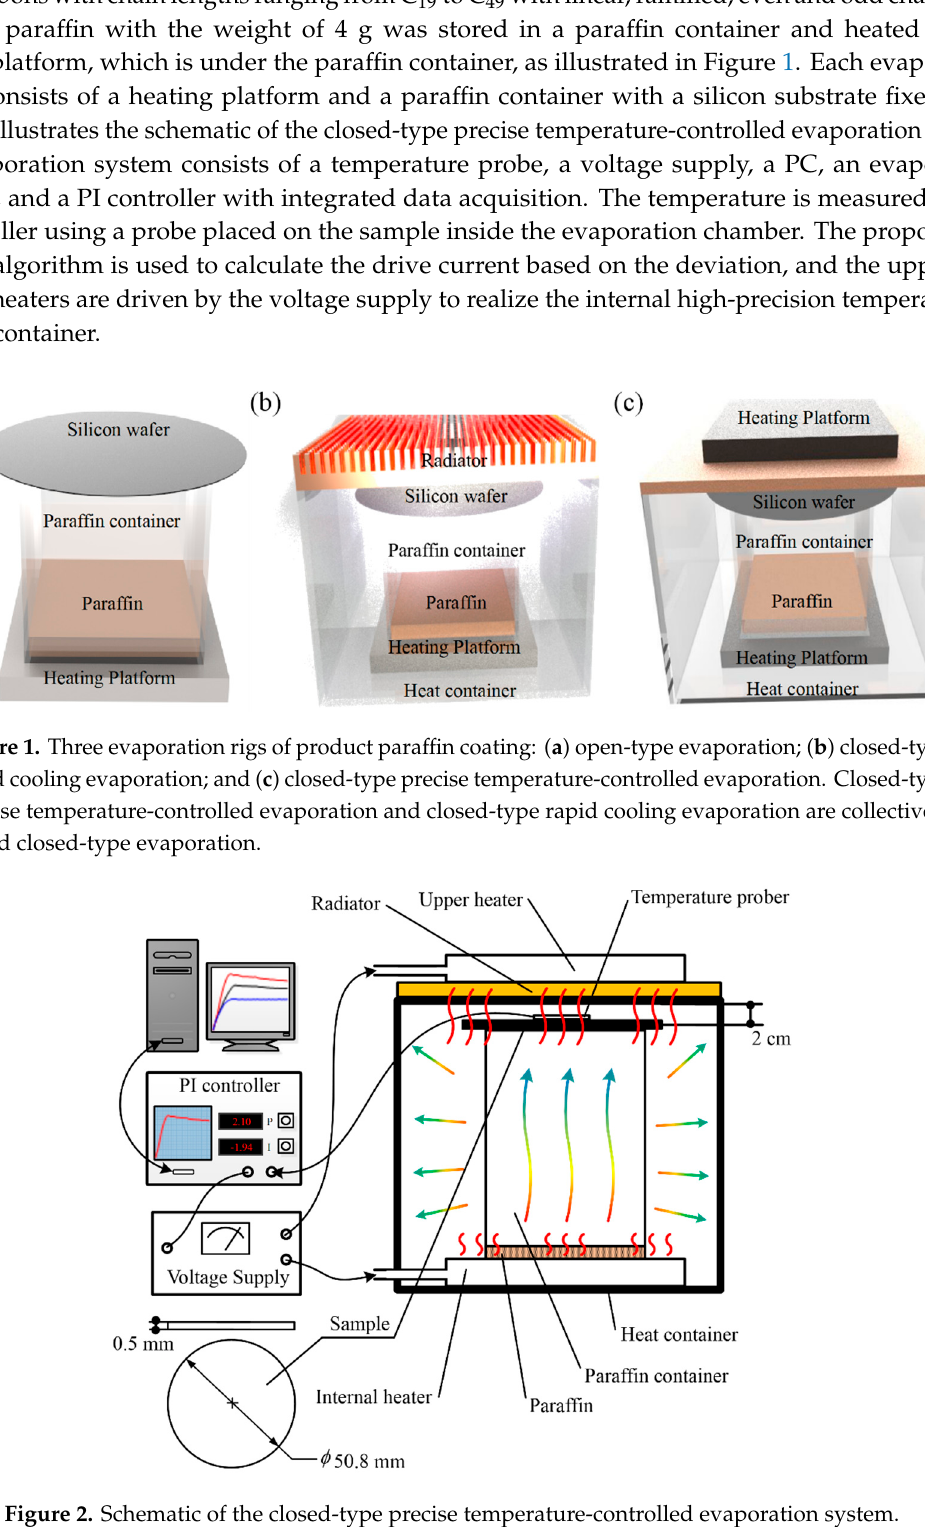
Figure 2. Schematic of the closed-type precise temperature-controlled evaporation system.